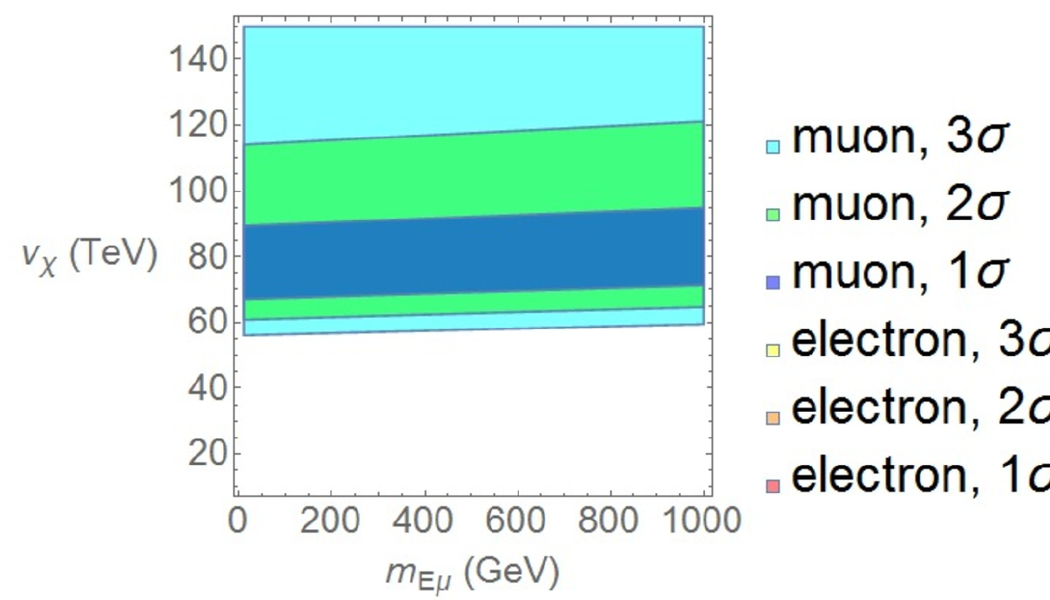
Figure 16 . Same as in (cid:12)gure 15 but now with m E